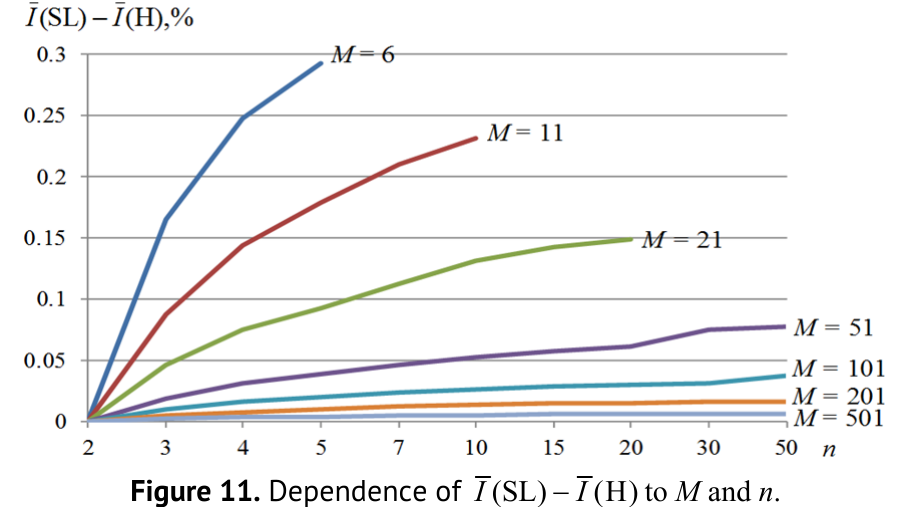
Figure 11. Dependence of